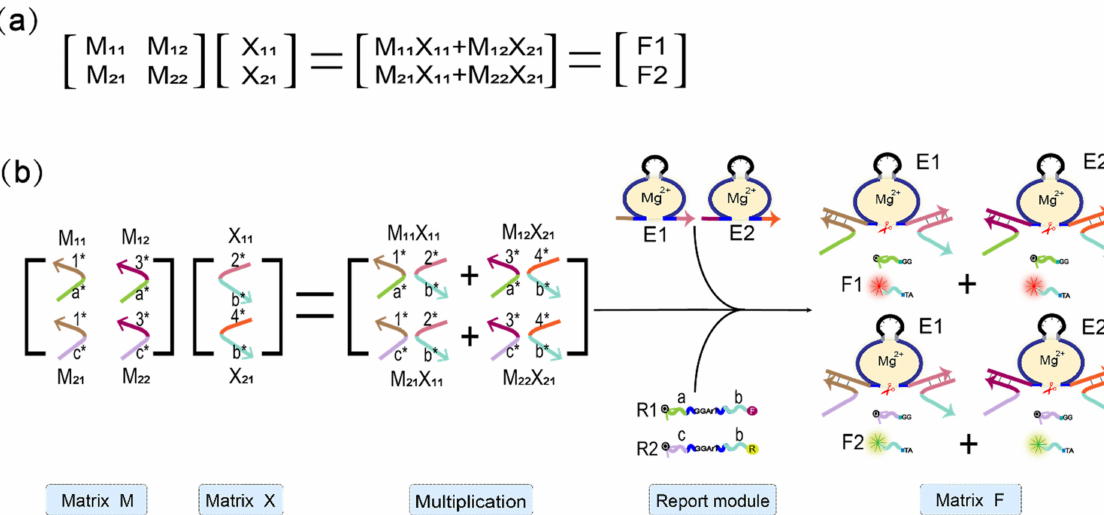
Figure 4. Boolean matrix multiplication reaction process diagram. ( a ) The mathematical principle of matrix M and matrix X multiplication. ( b ) Scheme diagram of the matrix M multiplied by the matrix X. The elements of the two matrices are represented by two auxiliary strands that constitute the mechanism of the DNAzyme binding to auxiliary strands to cleave the substrate. The reporting module consists of two DNAzymes and two substrate strands modified with FAM and ROX and quenching groups,